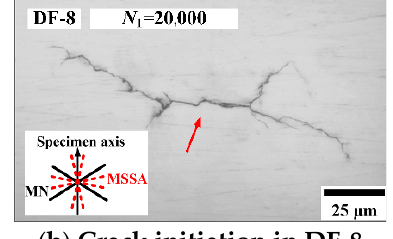
Figure 10. Crack morphologies in specimens DF-2 and DF-5.